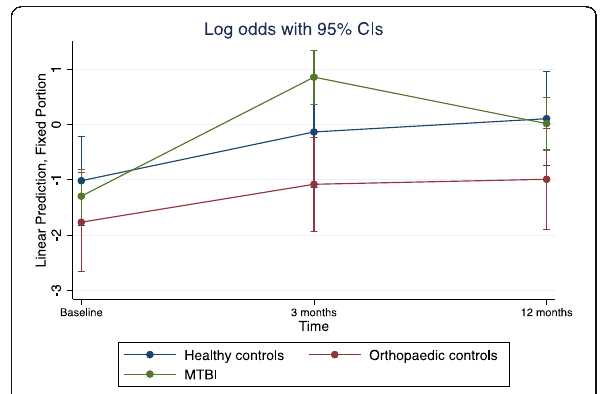
Fig. 1 (abstract P14). Log odds with 95% CI for headache pre- injury, 3 months and 12 months for all three participant